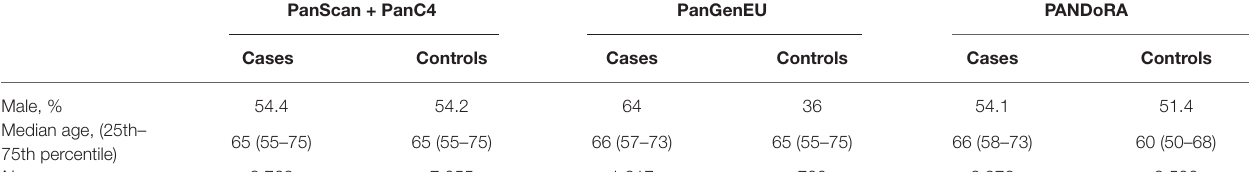
TABLE 1 | Description of the study populations.